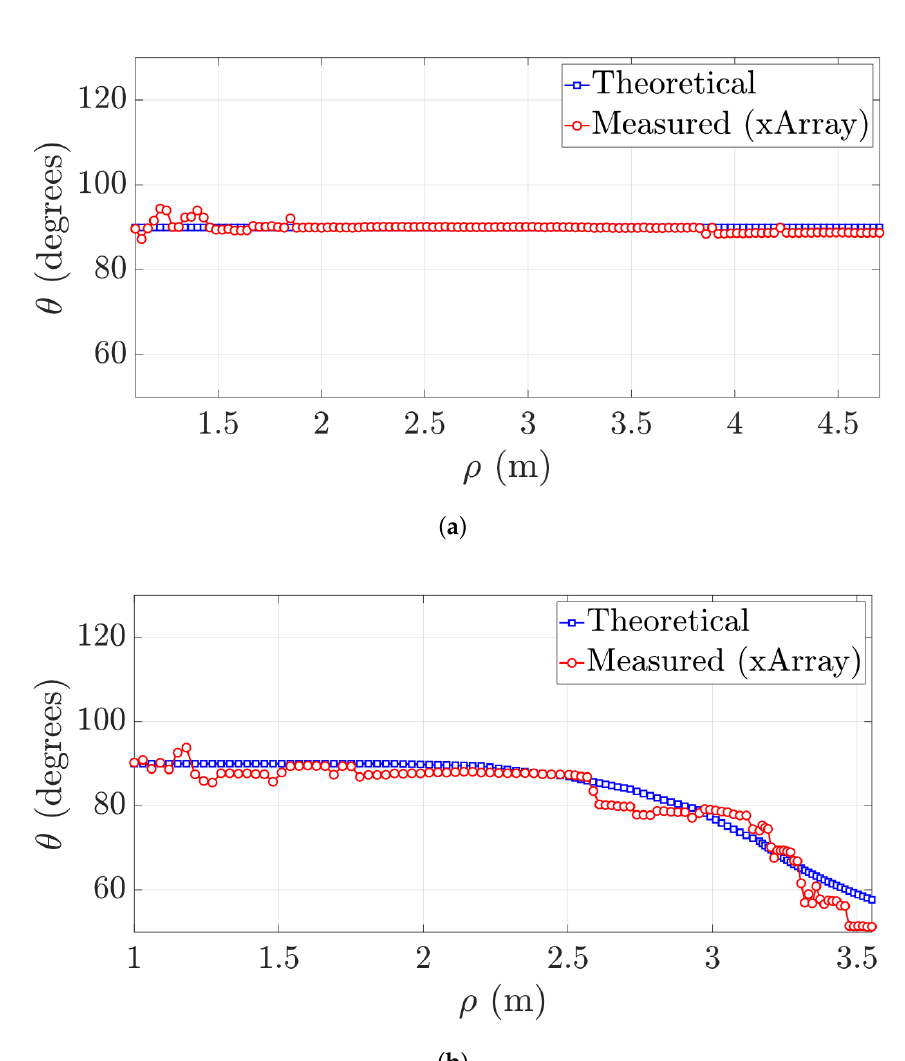
Figure 9. Actual (blue squared markers) and estimated (red circular markers) Direction of Arrivals when the tagged person moves according to the following: ( a ) a sample of a straight path and ( b ) a sample of an L-shaped trajectory.